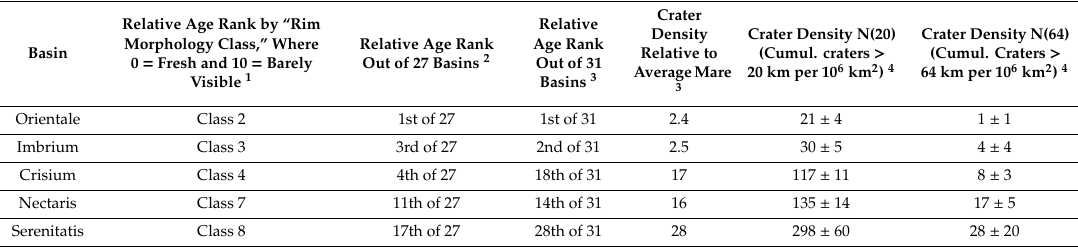
Table 2. Morphologicalandcrater-chronometricrelativeagesofthreebasins(fromfourindependentpapers). Crater Relative Relative Age Rank by “Rim Crater Density N(64) Density Crater Density N(20) Relative Age Rank Age Rank Morphology Class,” Where (Cumul. craters > (Cumul. Craters > Relative to Basin Out of 27 Basins 2 Out of 31 0 = Fresh and 10 = Barely AverageMare 20 km per 10 6 km 2 ) 4 64 km per 10 6 km 2 ) 4 Basins 3 Visible 1 3 Orientale Class 2 1st of 27 1st of 31 2.4 21 ± 4 1 ± 1 Imbrium Class 3 Crisium Class 4 4th of 27 18th of 31 17 117 ± 11 8 ± 3 Nectaris Class 7 11th of 27 14th of 31 16 135 ± 14 17 ± 5 Serenitatis Class 8 17th of 27 28th of 31 28 298 ± 60 28 ±